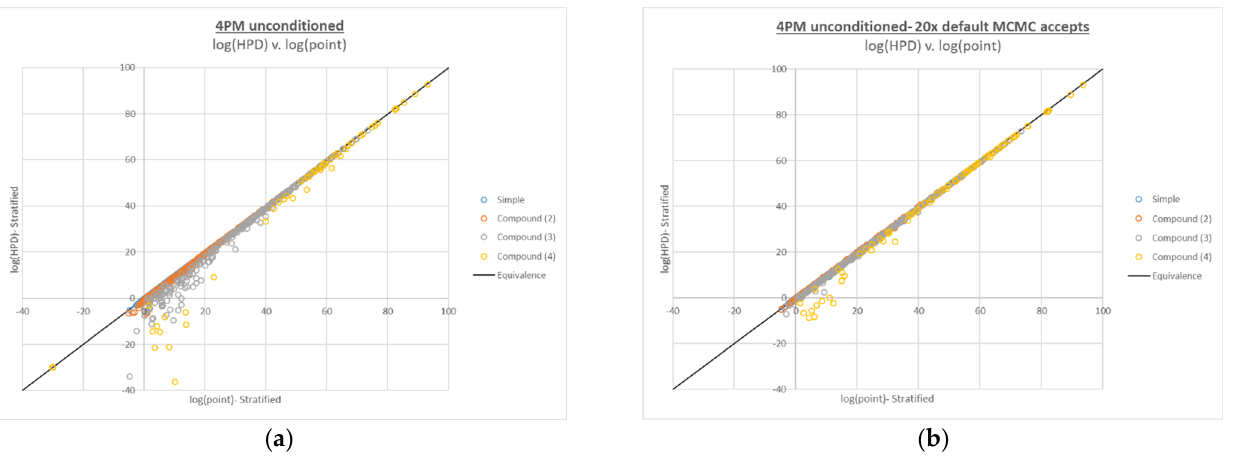
Figure A2. Plots of log(HPD LR) v. log(point estimate LR) for 4-person compound LR calculations at the default and 20x default MCMC accepts. The frequency of substantial drops in HPD increased with increasing numbers of contributors in the LR numerator ( a ), in parallel with the incidence of compound LR false negatives, and these occurred less frequently with the 20x MCMC accept setting ( b ).